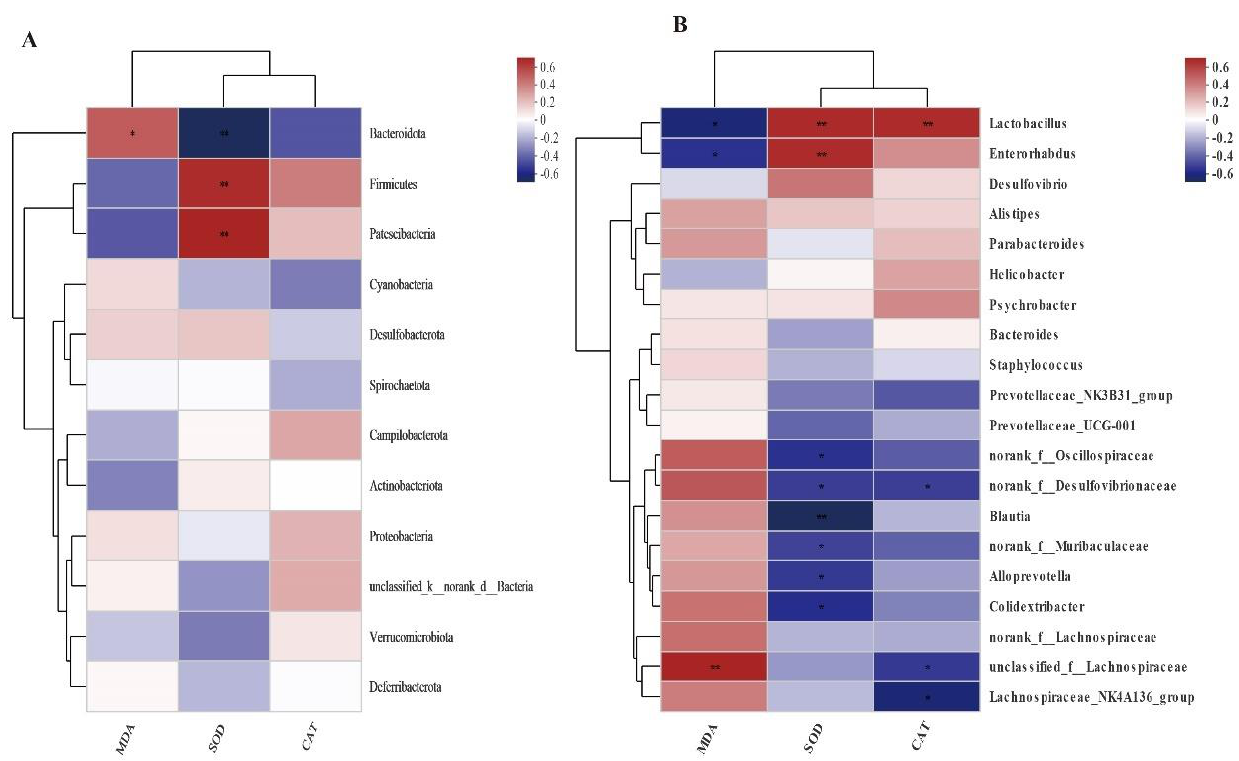
Figure 6. Spearman correlation analysis between serum MDA, SOD, CAT, and cecal flora genus level abundance. ( A ): phylum level ( B ): genus level. The Horizontal coordinate and Vertical coordinate are environmental factors and species, respectively. * p ≤ 0.05, ** p ≤ 0.01, *** p ≤ 0.001.